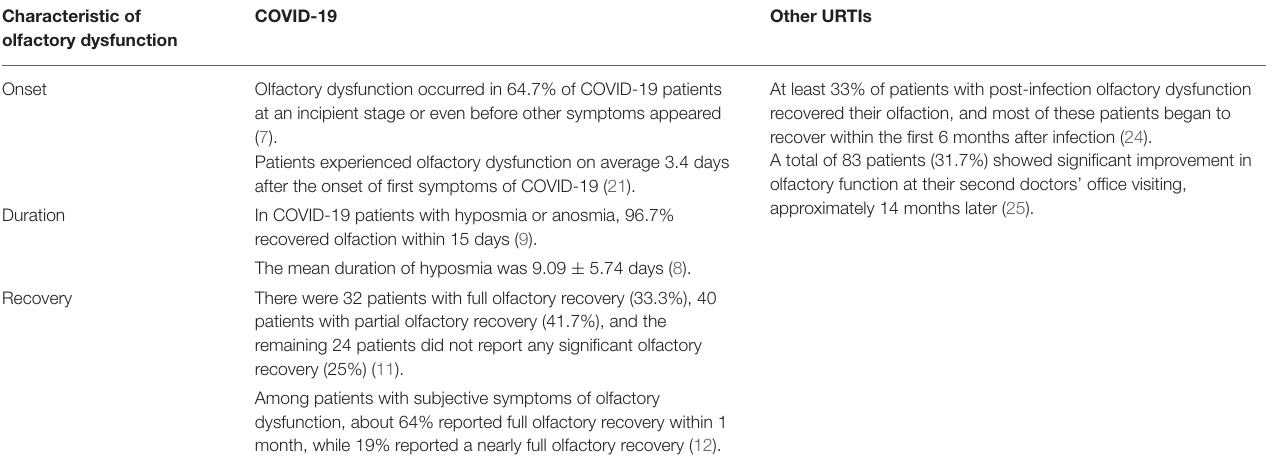
TABLE 2 | Characteristics of olfactory dysfunction attributed to COVID-19 vs. other viral UTRIs. Characteristic of olfactory dysfunction